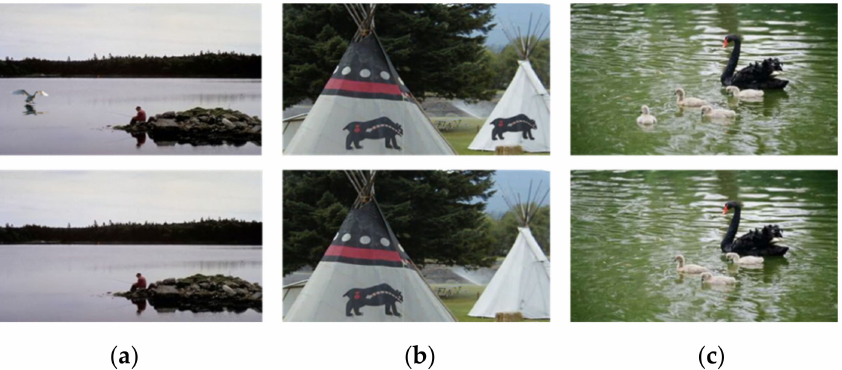
Figure 1. The figure demonstrates three types of image manipulation, namely ( a ) splicing, ( b ) copy–move, and ( c ) removal. The tampered images are on the top, and the authentic image are on the